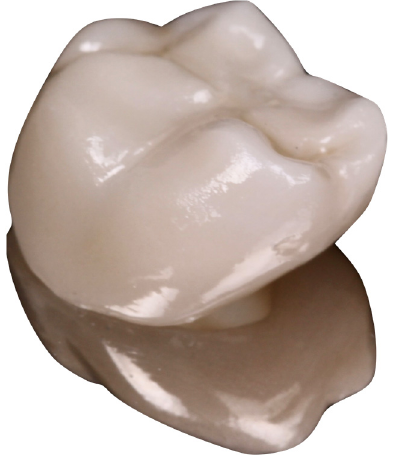
Figure 3. Finished MZC.